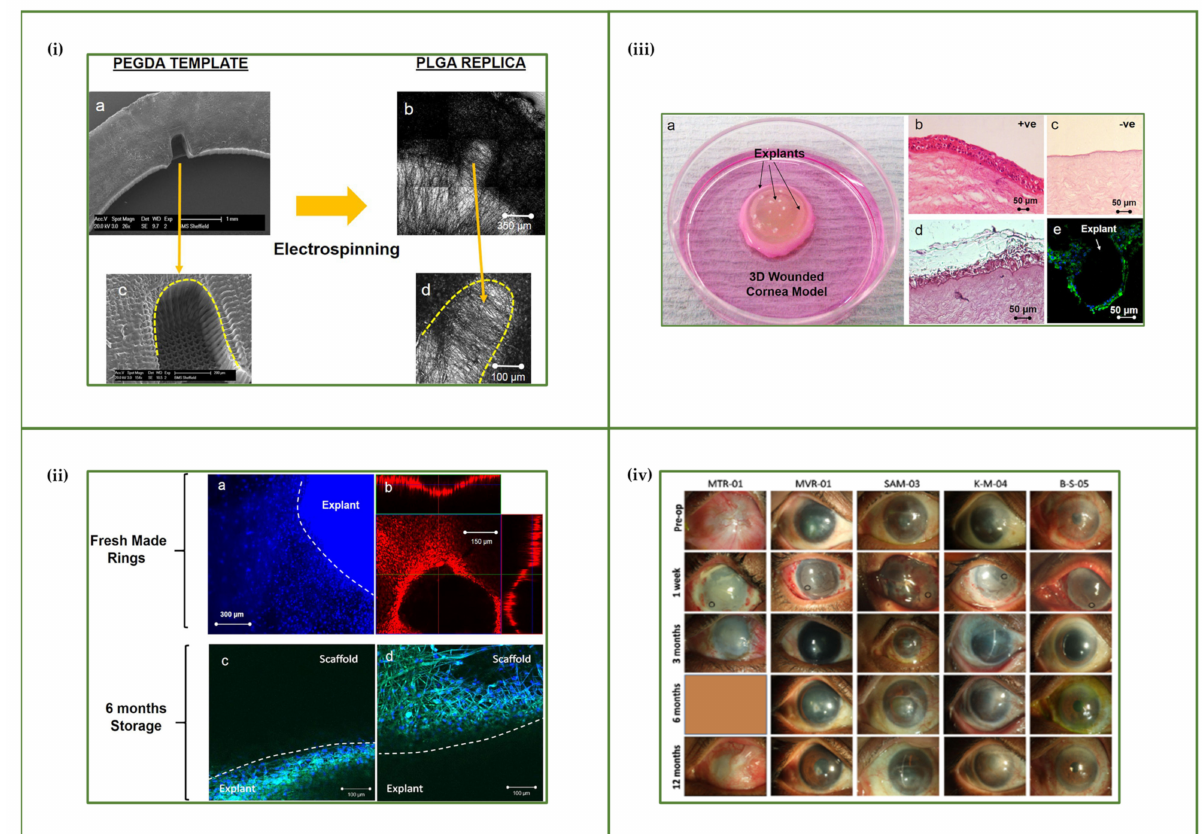
Figure 4. ( i ) The SEM images of the microfabricated pocket electrospun by PLGA onto a PEGPA ring with a horseshoe microfeature. ( ii ) Fluorescence images showing outgrowth of limbal epithelial cells (LEC) from limbal explants cultured on freshly made biodegradable PLGA rings and on rings after 6 months storage at − 20 ◦ C (DAPI = blue, Propidium Iodide = red, and positive staining for p63 = green). ( iii ) Demonstrates the rabbit wounded cornea model with panel A illustrating the image of the ring scaffold cultured with the tissue explants. In panel B a fresh rabbit cornea is shown as the positive control; whilst for the negative control the epithelium is removed from the cornea and cultured for 4 weeks as shown in panel C. The H&E image shows the new multi-layered epithelium formed due to cell outgrowth from the limbal explants after 4 weeks in culture in panel D. The immunocytochemistry image shown in panel E illustrates cell outgrowth from a limbal explant (DAPI = blue and positive staining for cytokeratin 3 = green). ( iv ) The first in-man study performed on five patients is shown in the images of the pre-treatment and post-treatment over 1 year. At week 1 the location of explants on the ocular surface are represented with circles and by the 3 months check-up the PLGA membrane was not observed on the ocular surface indicating complete degradation. Reprinted with permission from Ortega et al. (2014) for ( i – iii ) and Ramachandran et al. (2021) for ( iv )